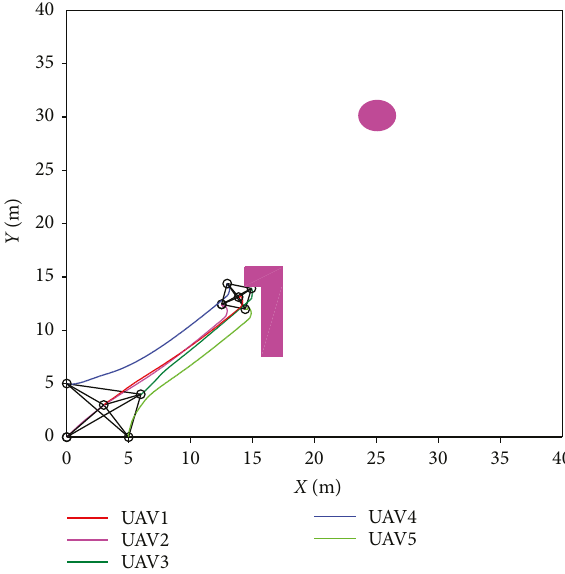
Figure 14: The consensus formation reaches the local minima.